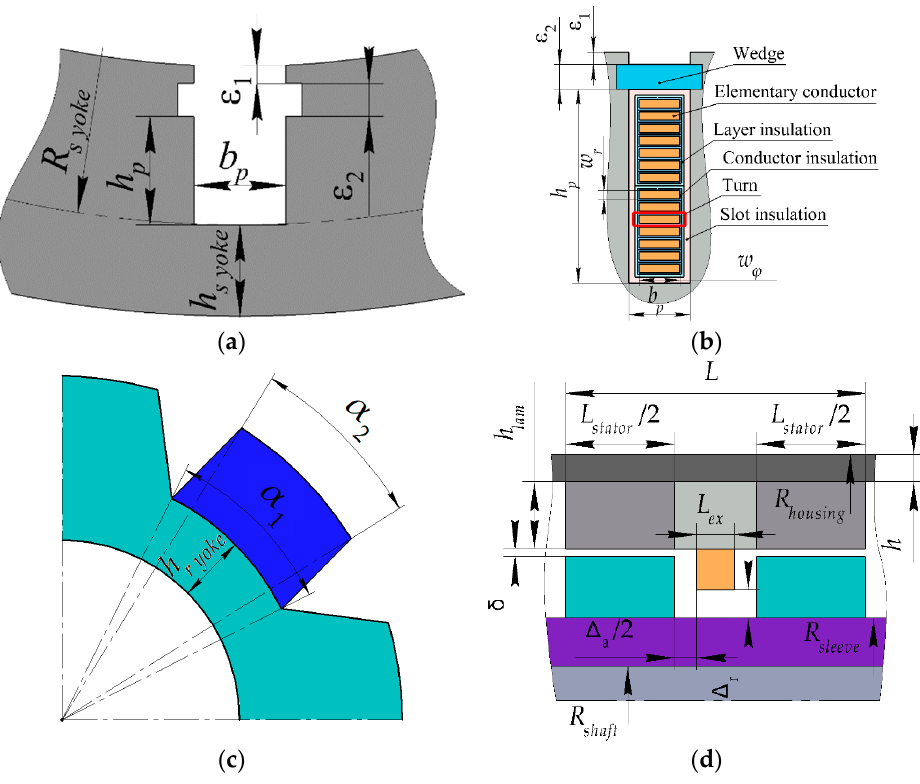
Figure 5. SHM parameters. ( a ) Stator; ( b ) Armature winding; ( c ) Rotor; ( d ) Axial